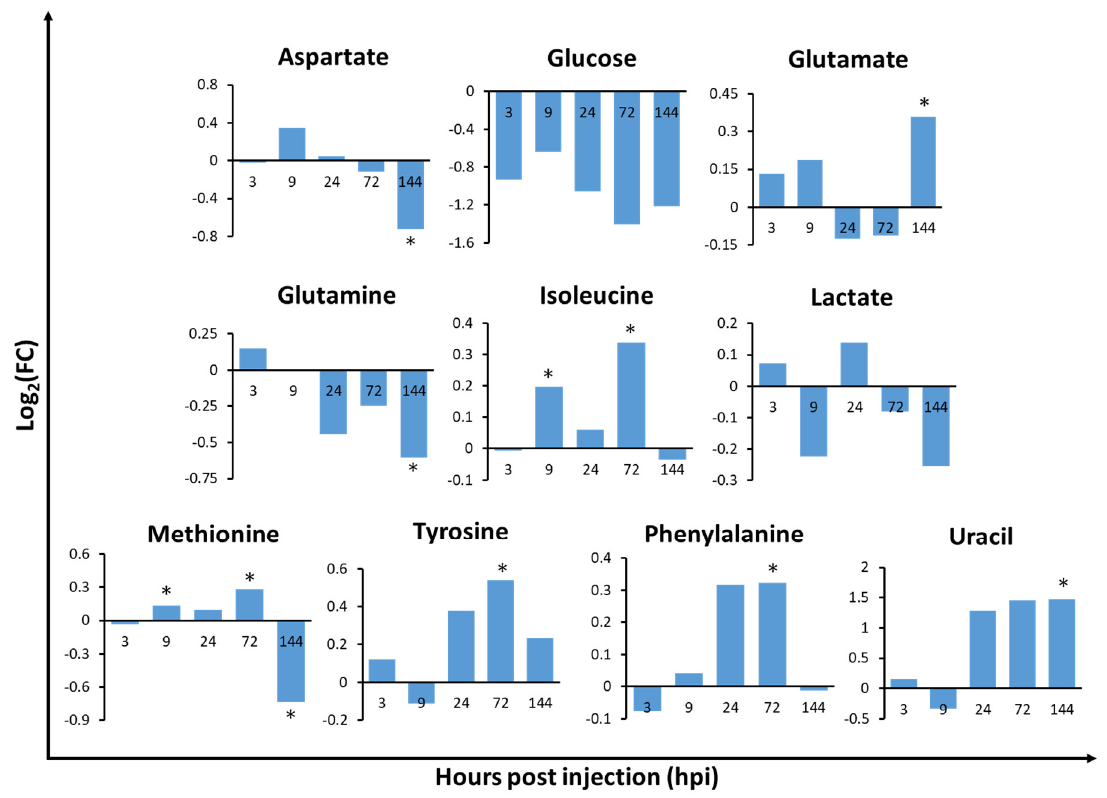
Figure 4. Fold change of relative metabolite concentrations in the hepatopancreas of whiteleg shrimp ( Litopenaeus vannamei ) infected with Vibrio harveyi when compared to 0 hpi in the control group. Values with an asterisk (*) indicate significant differences between the control and infected group ( p < 0.05) ( n = 3).